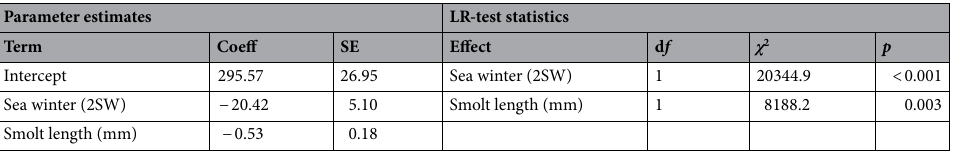
Table 1. Logit-parameter estimates and corresponding likelihood-ratio test statistics for the most supported model fitted to predict arrival time (DOY = Day of Year) to River Nidelva for Atlantic salmon spawners PIT tagged as smolts (smolt length) that had spendt one (1SW) or two (2SW) winters at sea before returning to spawn in River Nidelva.